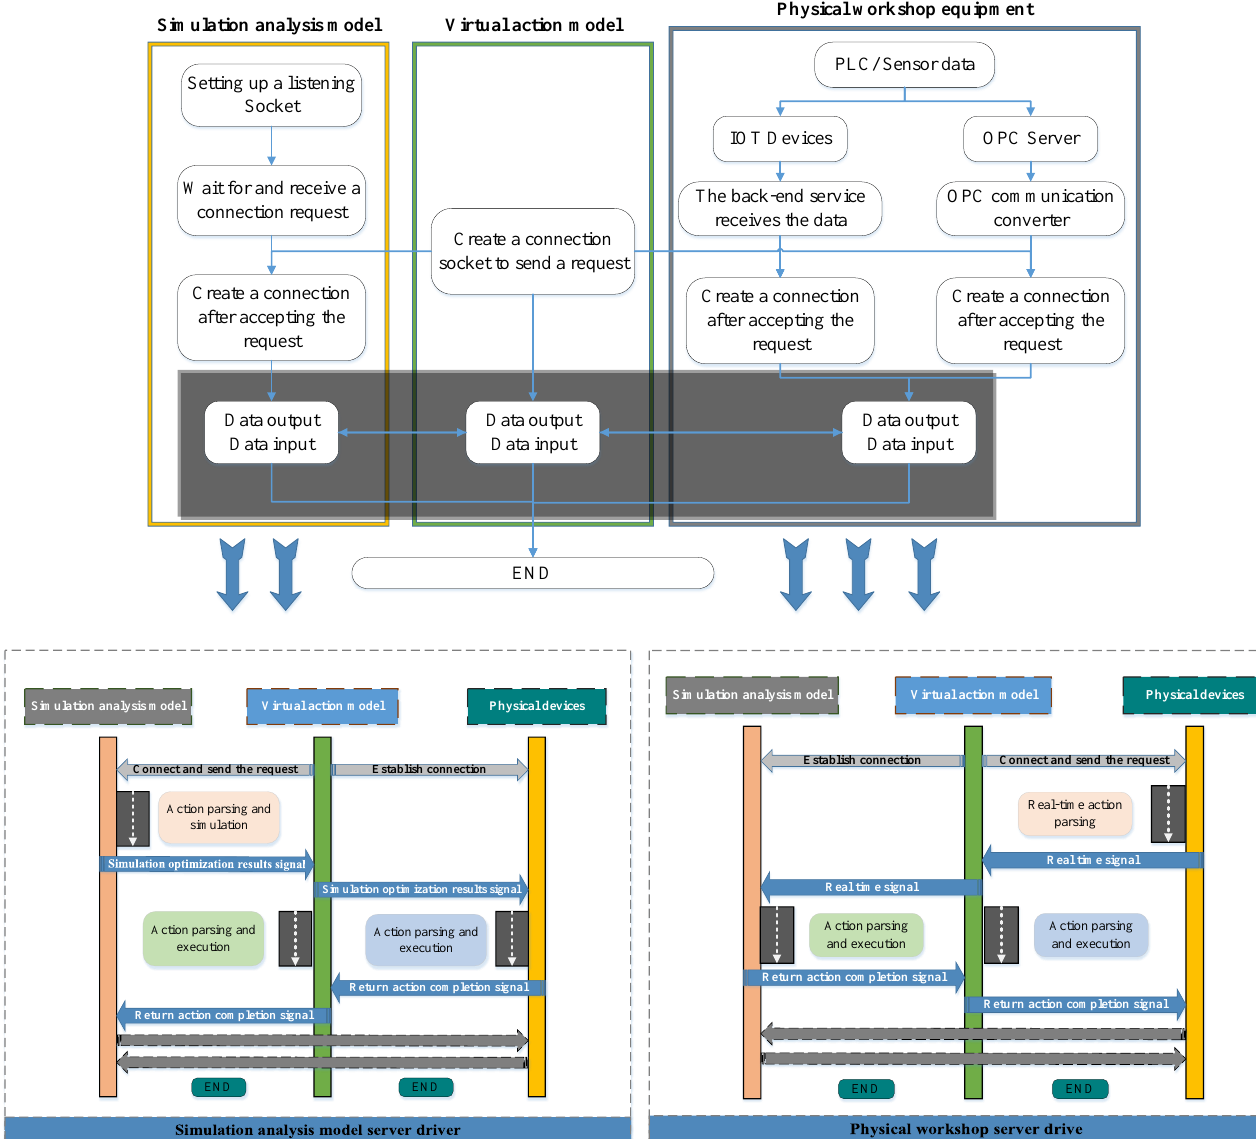
Figure 5. Interaction between virtual action model, simulation analysis model and a physical de- vice.